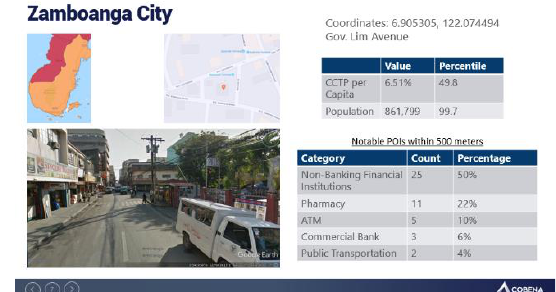
Figure 15. Potential site for a new bank branch in Zamboanga